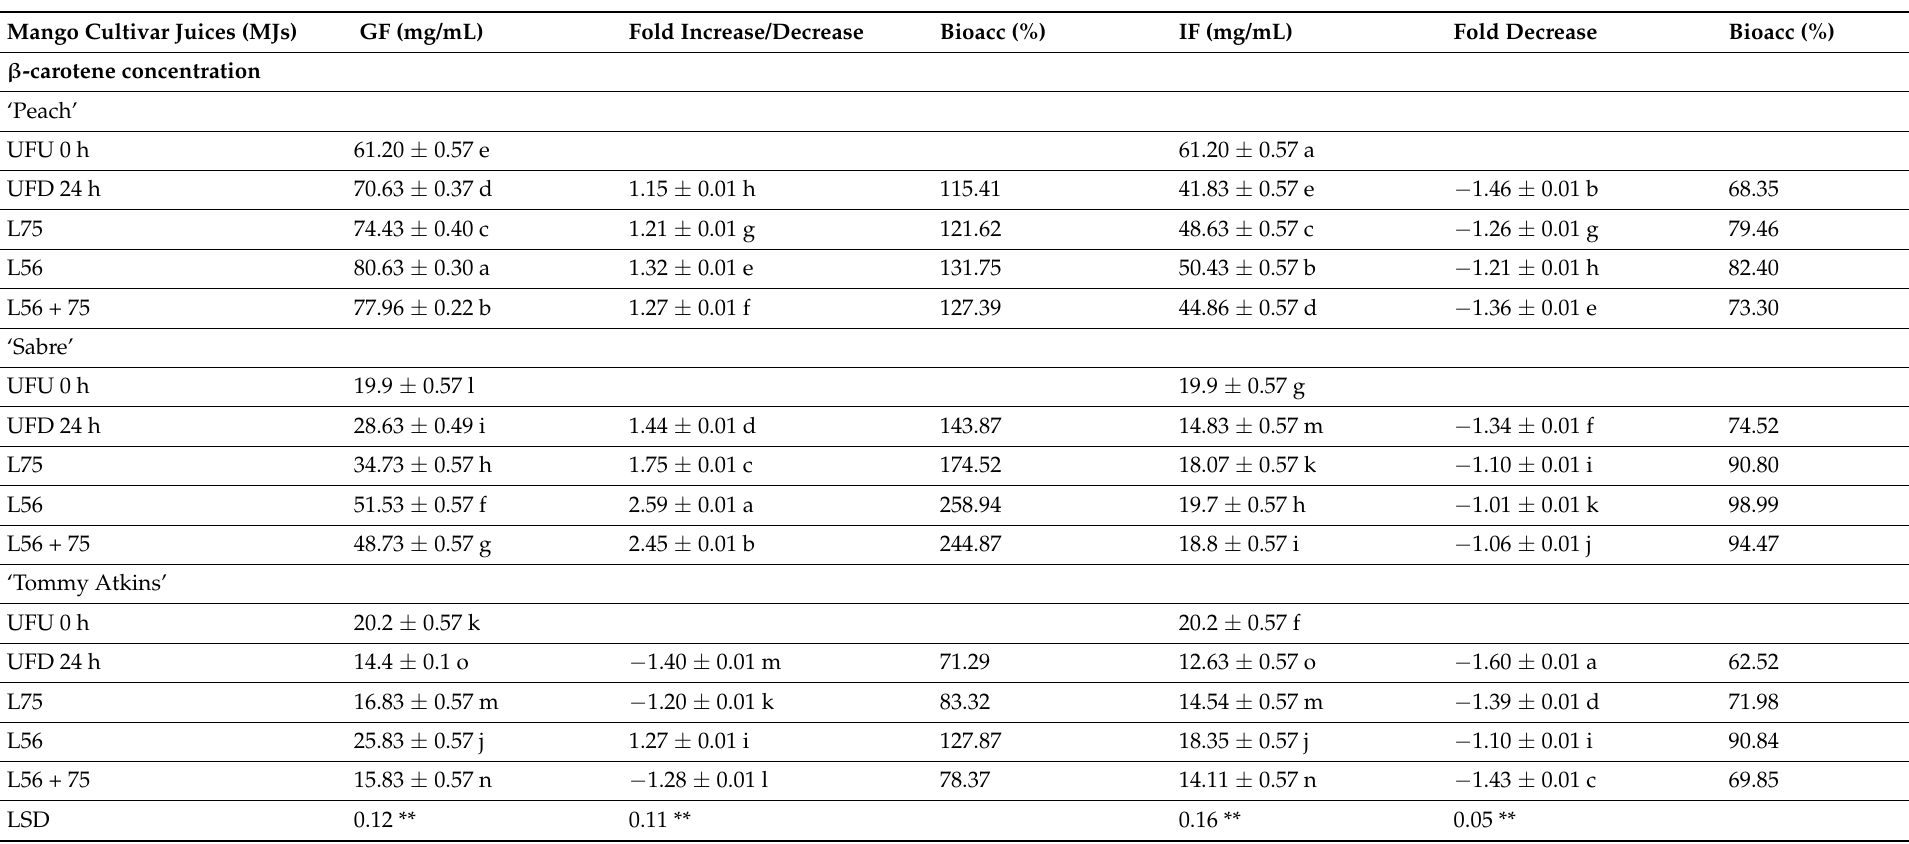
Table 2. Carotenoid profile of MJs from different cultivars fermented with LAB after in vitro GI digestion. Mango Cultivar Juices (MJs) GF (mg/mL) Fold Increase/Decrease Bioacc (%) Fold Decrease Bioacc